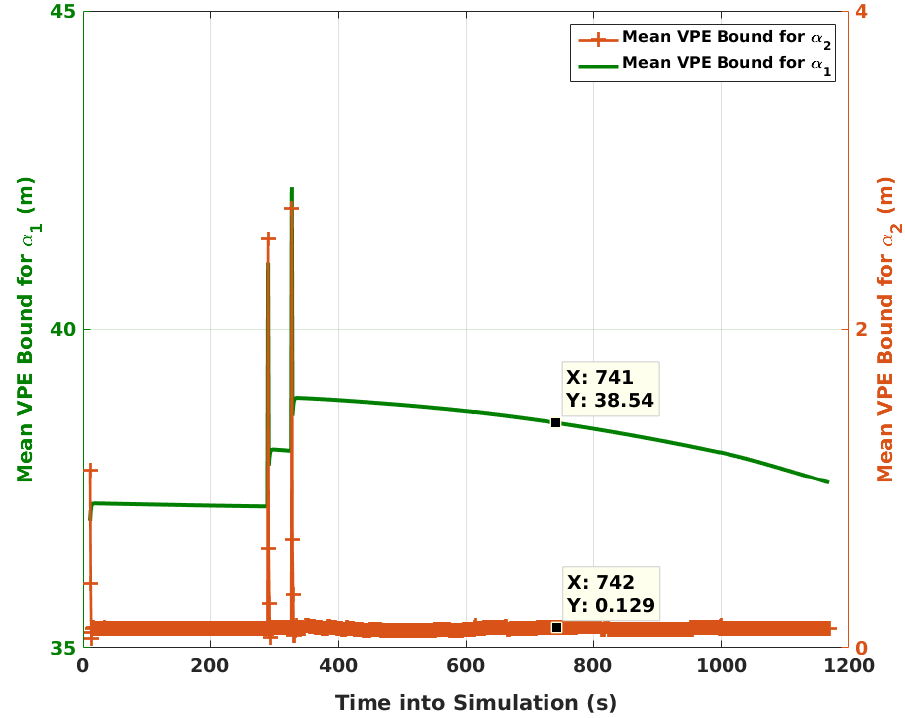
Figure 10. Mean VPE bounds corresponding to α 1 and α 2 after an initial transient period of 15 s. It should be noted that the sudden change around 350 s is caused by the change in FMS, not in Γ .